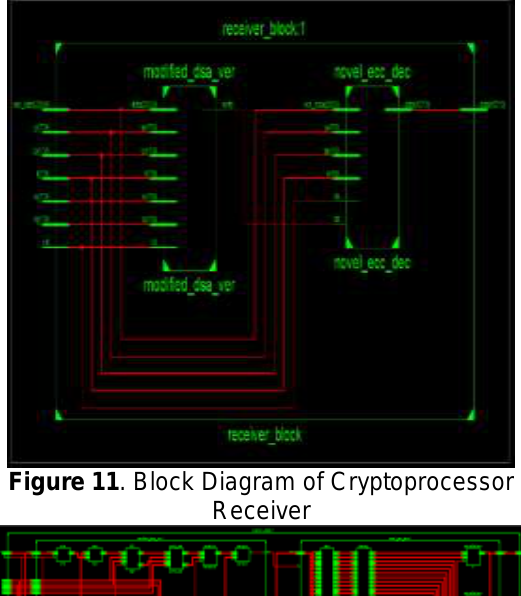
Figure 11 . Block Diagram of Cryptoprocessor Receiver